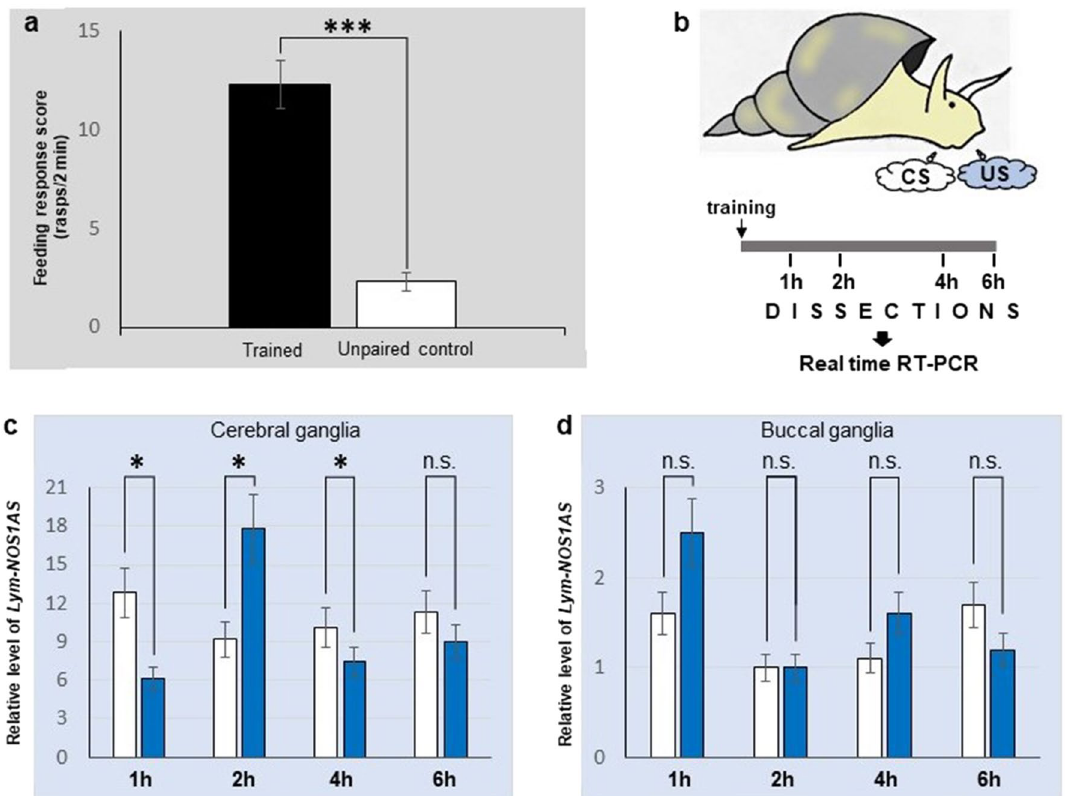
Figure 4. Training-induced differential regulation of the Lym-NOS1AS . ( a ) The result of the behavioural test of LTM formation at 24 h after training. The mean feeding response to amyl acetate (the CS) of the classically conditioned animals (black bar) is significantly higher than the response of the unpaired control animals (white bar) (n = 15 animals per group, two-tailed t-test for independent samples: t = 6.94, df = 28, p < 0.0001). ( b ) Schematic representation of the experiment to investigate whether single-trial reward conditioning is associated with timed and targeted changes in the expression of Lym-NOS1AS . ( c , d ) Results of real-time RT-PCR performed on the cerebral and buccal ganglia, respectively. The relative level of Lym-NOS1AS expression in ganglia from conditioned (blue bars) and unpaired control animals (white bars) dissected at 1 h, 2 h, 4 h and 6 h after training was calculated as 2 −ΔΔCt . All data in this figure are shown as means ± SEM. Asterisks indicate significant differences ( p < 0.05) between the conditioned and unpaired data at the same time point (n = 20 animals per group, unpaired two-tailed t-tests with Welch’s